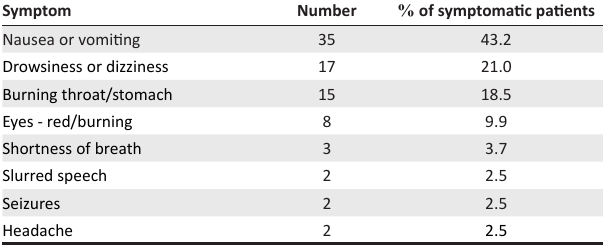
TABLE 3-A1: Common symptoms following hand sanitiser exposure recorded by the Poisons Information Helpline of the Western Cape during the first six months of the COVID-19